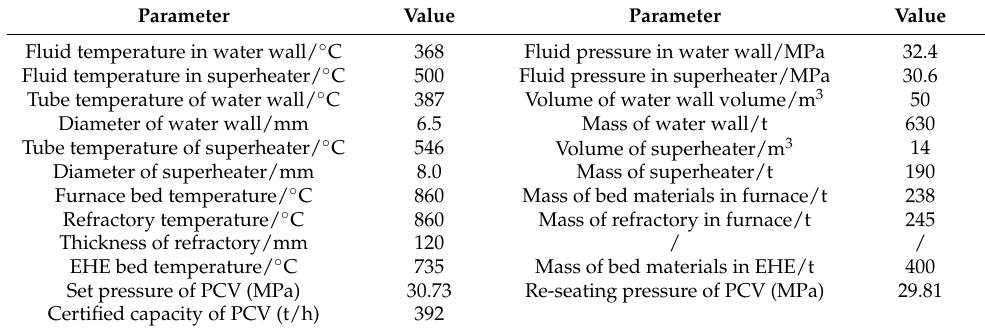
Table 3. Initial values of